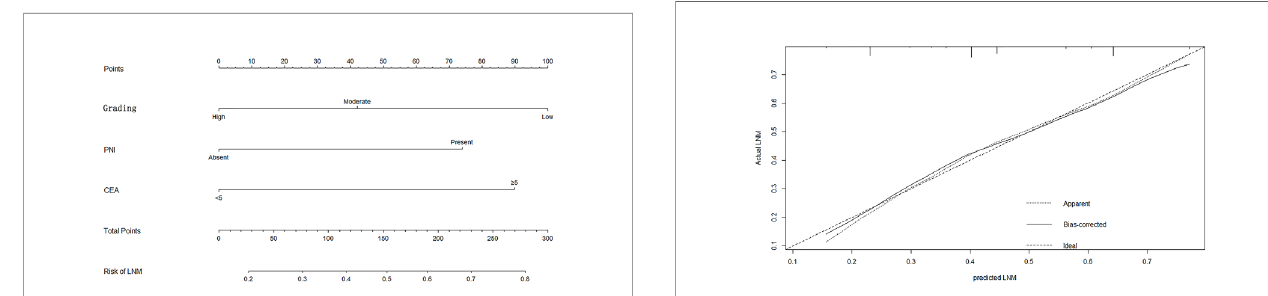
FIGURE 3 | The calibration plot showed a high fi t between actual and predicted lymph node metastases in training